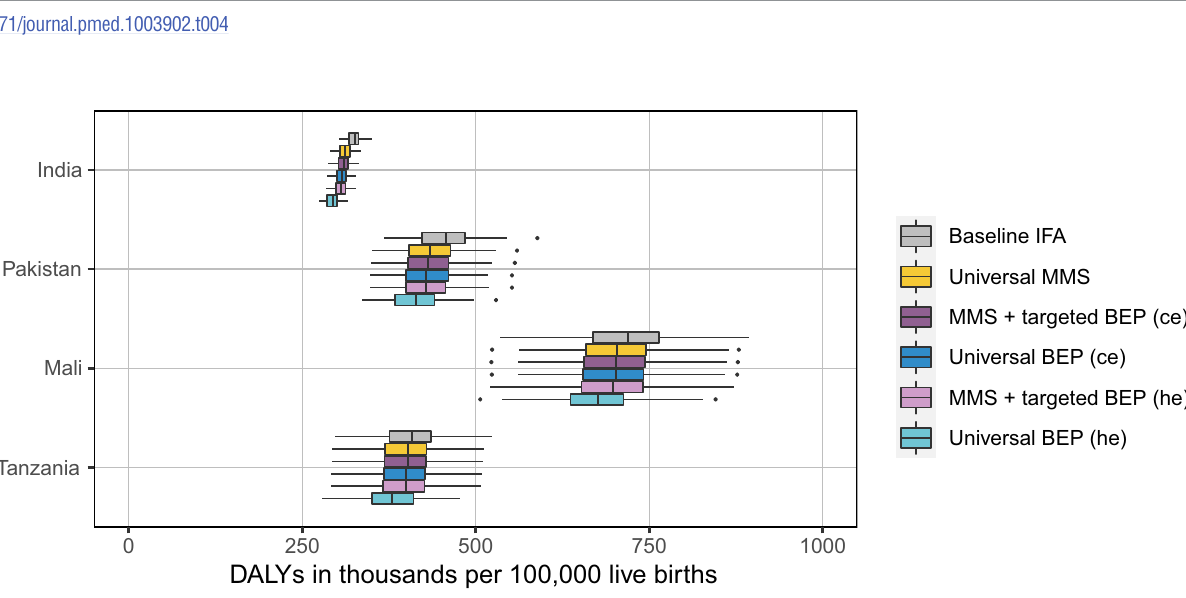
Fig 3. DALYs due to all causes among children under 2 in thousands per 100,000 live births in each simulated supplementation scenario by location. The width of the colored boxes represents the interquartile range (25th to 75th percentiles); the solid line in the box represents the median (50th percentile); the whiskers on either end of the box represent the minimum and maximum values; and the points represent outlier values. BEP, balanced energy protein; ce, scenarios with current evidence effects for BEP; DALY, disability-adjusted life year; he, scenarios with hypothesized effects for BEP; IFA, iron and folic acid; MMS, multiple micronutrient supplementation.